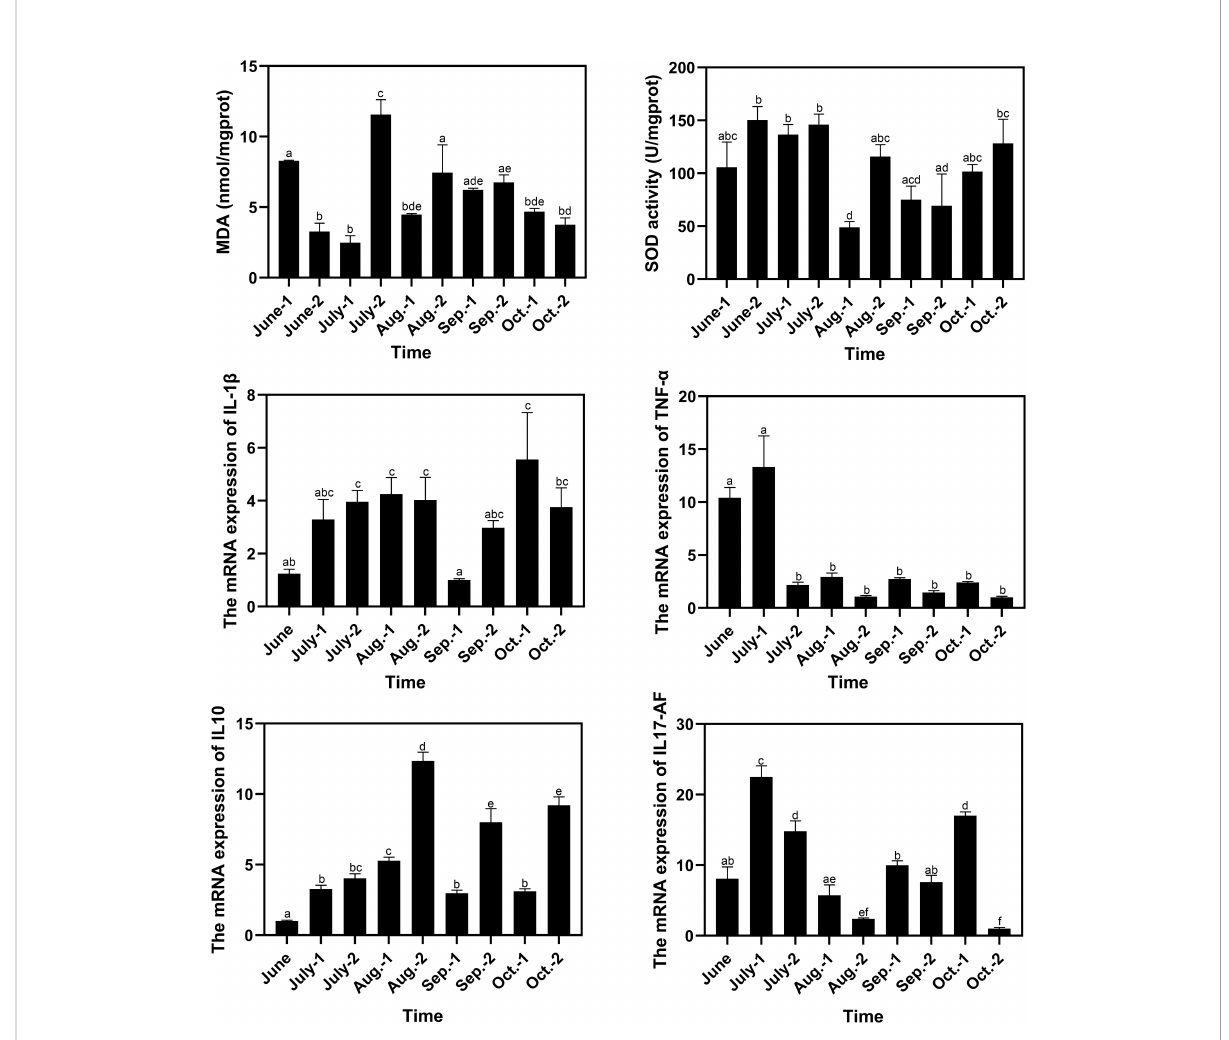
FIGURE 6 Variation of immune response parameters of puffer fi sh during the aquaculture period. The letters above the bars indicate the signi fi cance of differences between groups; the groups with different letters have signi fi cant differences (P <